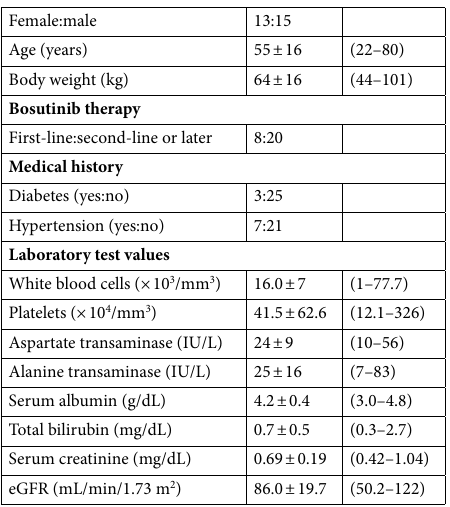
Table 1. Demographic and clinical characteristics of patients prior to bosutinib therapy. Data are presented as the mean ± standard deviation (range) or number (%).